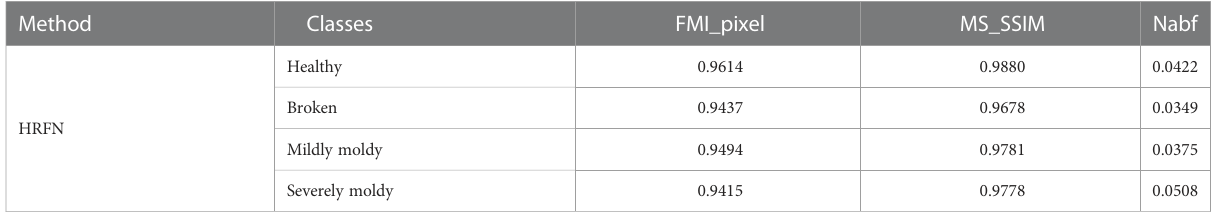
TABLE 1 Fusion performance of HSI and RGB using